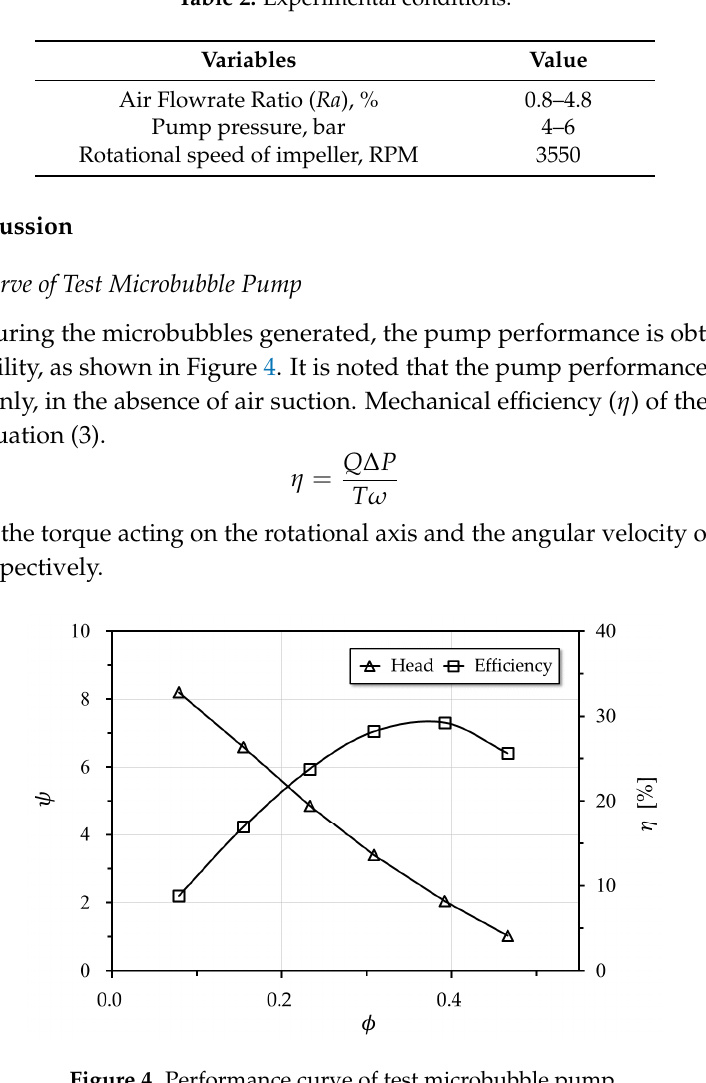
Figure 4. Performance curve of test microbubble pump.